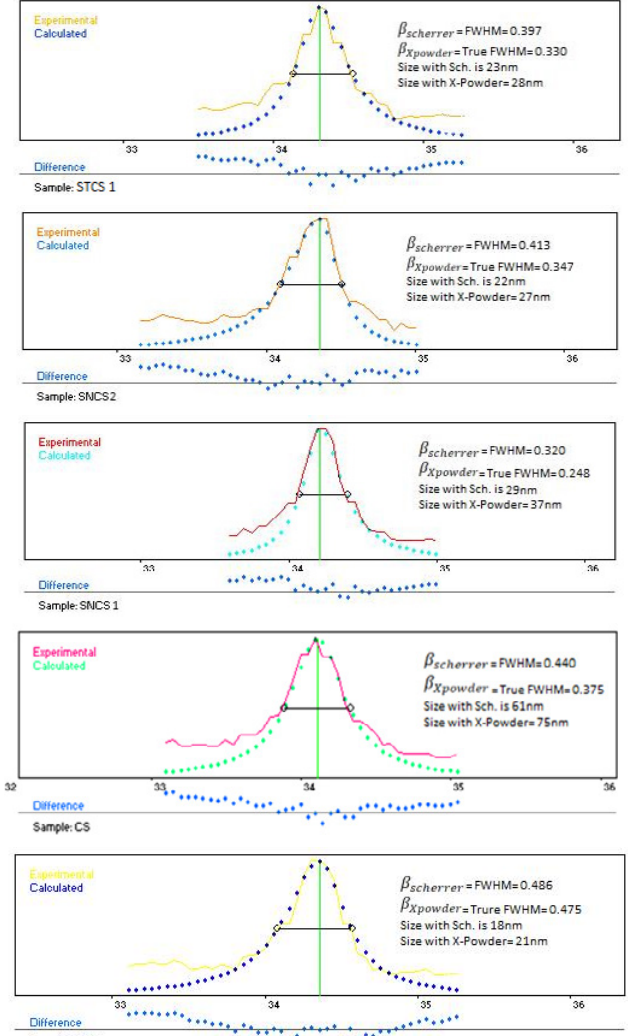
Figure 8. Size of nanocrystallite for the control sample, cement paste containing nano- TiO 2, NM particles and MWCNT-COOH calculated with the Scherrer equation and X- powder technique.